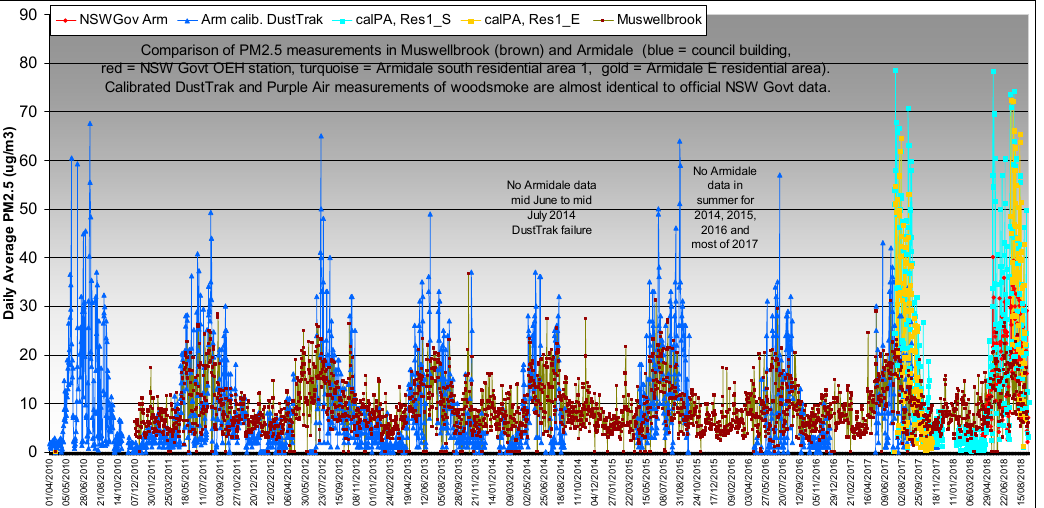
Figure 5. Daily average PM 2.5 , 2010–2018, at the NSW government air pollution stations in Muswellbrook (brown) and Armidale (red), DustTrak PM 2.5 (blue, wood smoke calibration) at Armidale Regional Council building and calibrated PurpleAir PM2.5 measurements (gold & cyan) at two locations in Armidale.